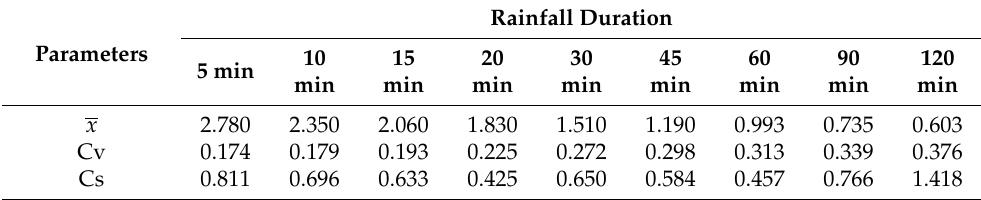
Table 1. The parameters of Pearson-3 type distribution for reference (RF) period.